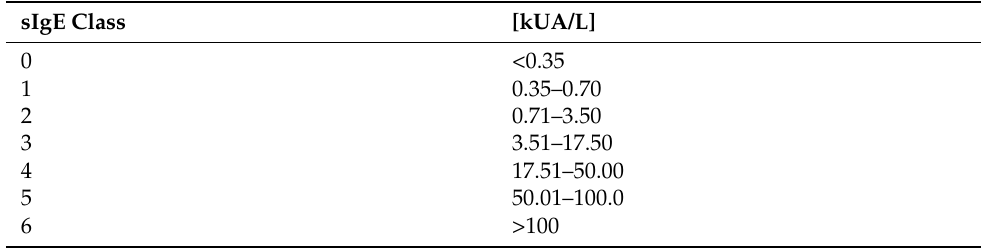
Table 4. Concentration range of sIgE